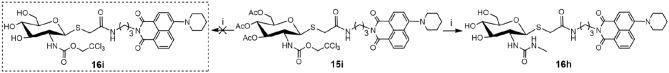
New method for the synthesis of thioglycosyl–naphthalimides 16h (i) CH3NH2, MeOH.